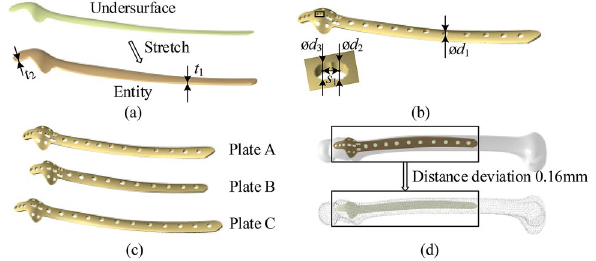
Figure 7. Parameter variation of the features in the eagle-shaped plate: ( a ) entity generated from undersurface, ( b ) punch holes and set parameters, ( c ) plates with different parameters. Plate A : l 1 = 229 mm; l 2 = 39